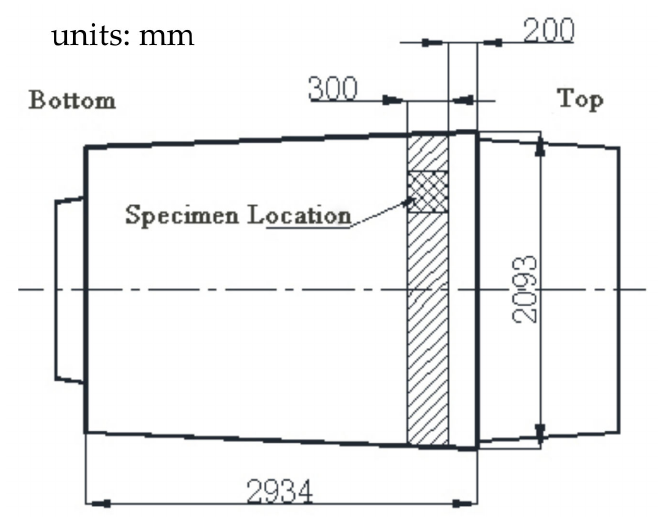
Figure 1. The gating system of the tested steel.